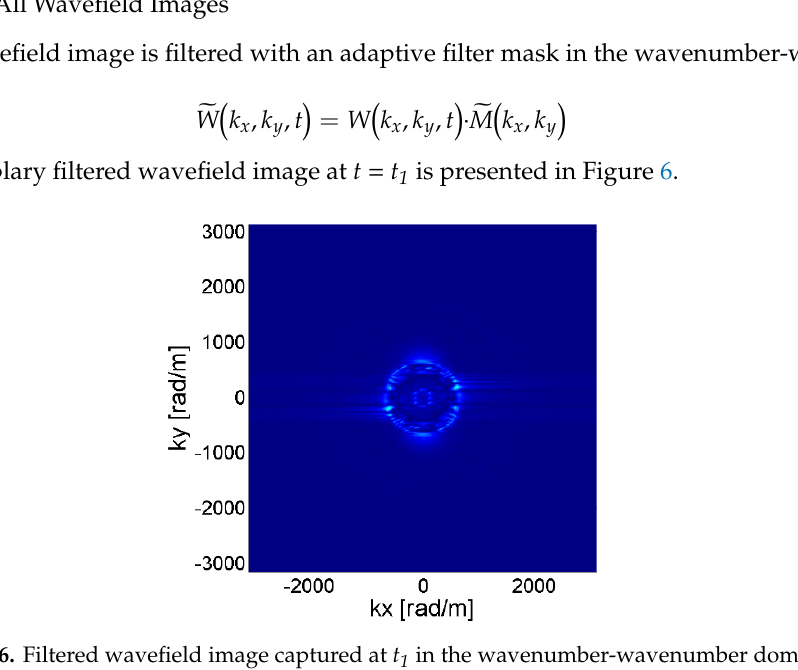
Figure 6. Filtered wavefield image captured at t 1 in the wavenumber–wavenumber domain.